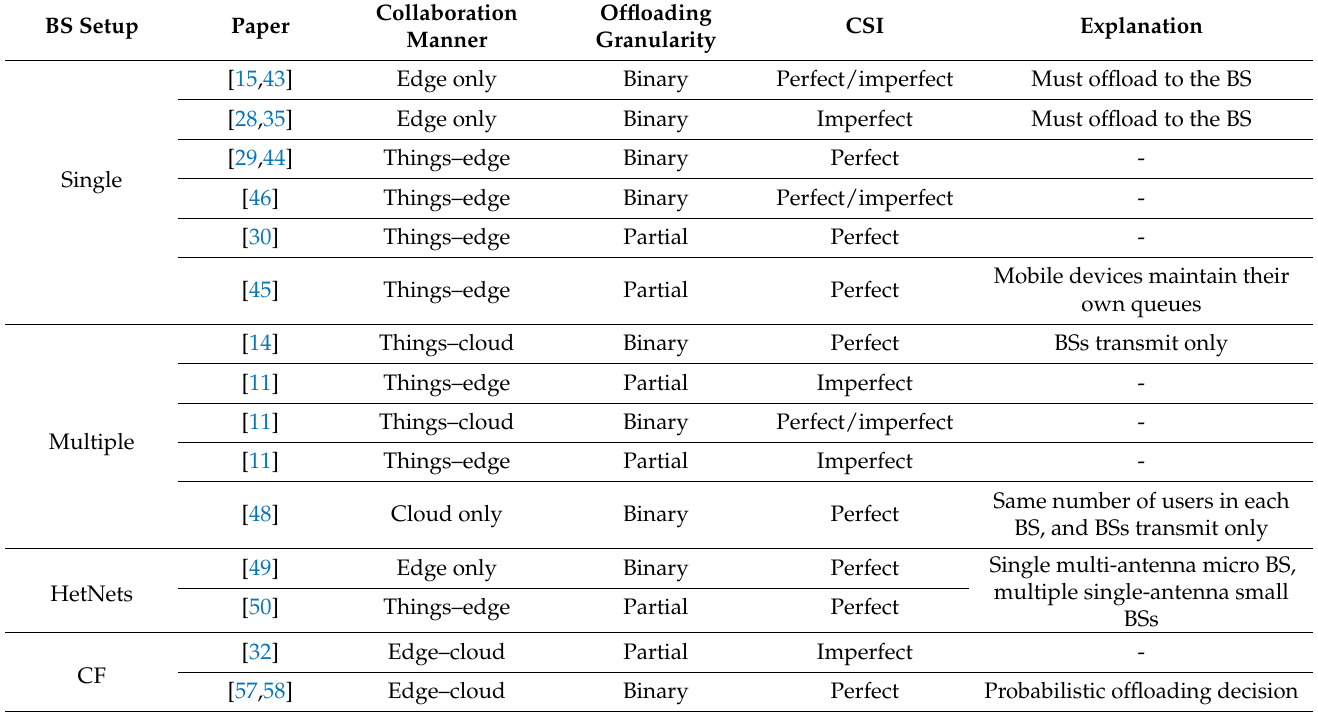
Table 2. Comparison of papers about research scenarios in